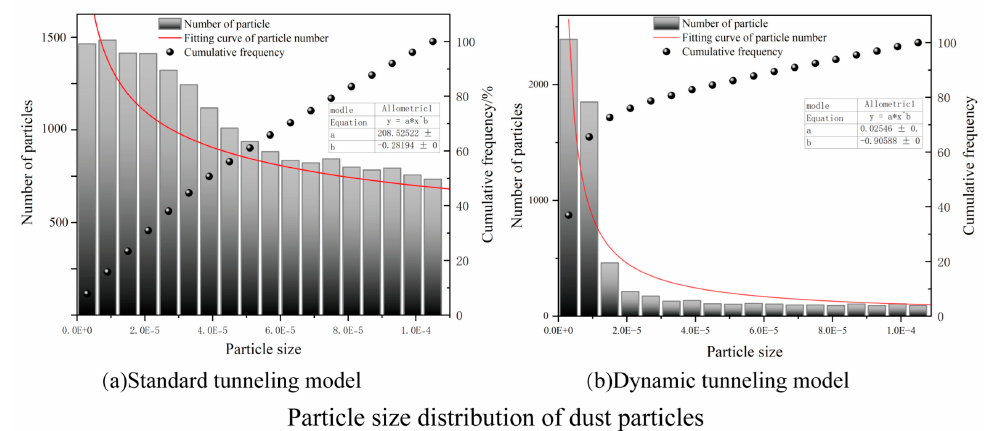
Figure 19. Particle size distribution of dust particles.